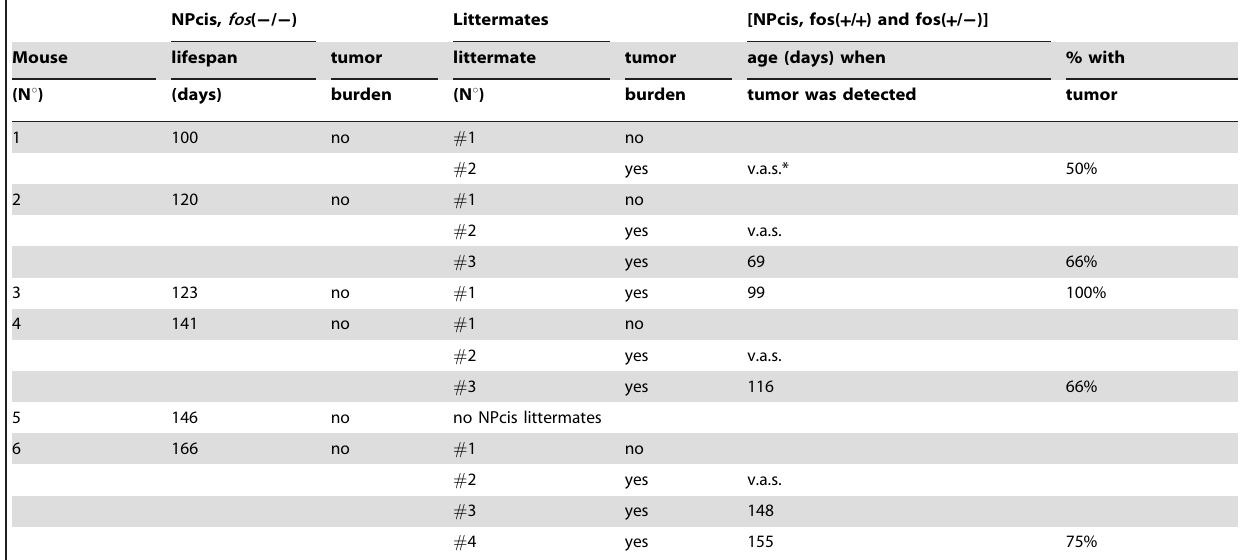
Table 1. NPcis, fos ( 2 / 2 ) mice do not generate